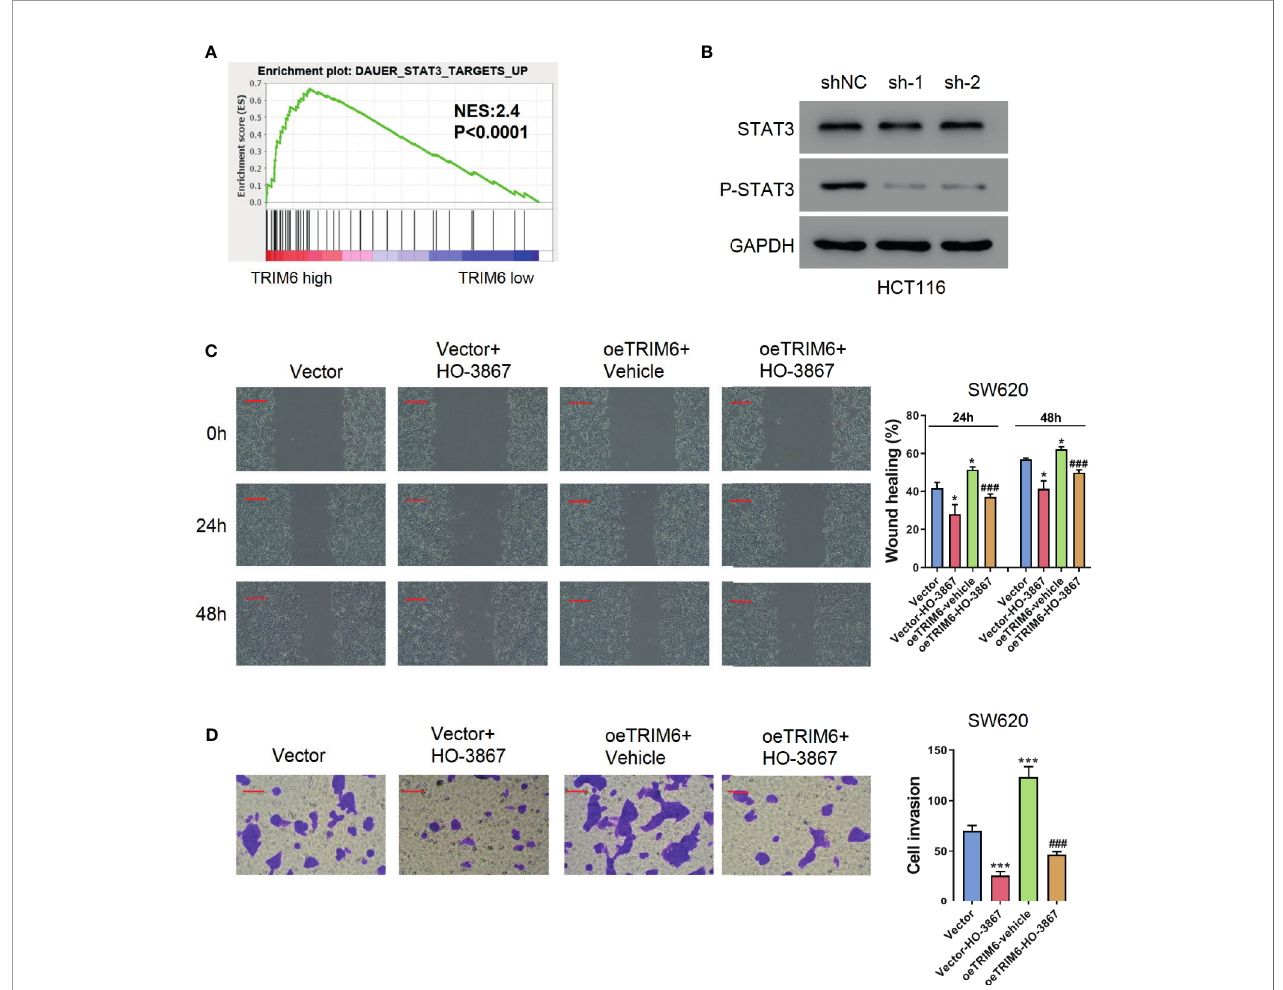
FIGURE 3 | TRIM6 overexpression induces CRC cell migration via the STAT3 pathway in the SW620 cell line. (A) Enrichment plot of GSEA of the TRIM6 target. (B) STAT3 and p-STAT3 expression level detected via Western blot in TRIM6 knockdown HCT116 cells. (C) Representative images and quantitative analysis of the wound-healing assay in TRIM6-overexpressed SW620 cells with/without HO-3867 treatment at 0, 24, and 48 h post-scratching. Scale bar: 100 µm. (D) Representative images and quantitative analysis of the cell invasion assay in TRIM6-overexpressed SW620 cells with/without HO-3867 treatment. Scale bar: 100 µm. *P < 0.05, ***P < 0.001 vs. Vector; ### P < 0.001 vs. oeTRIM6 + Vehicle. The results are from at least three separate